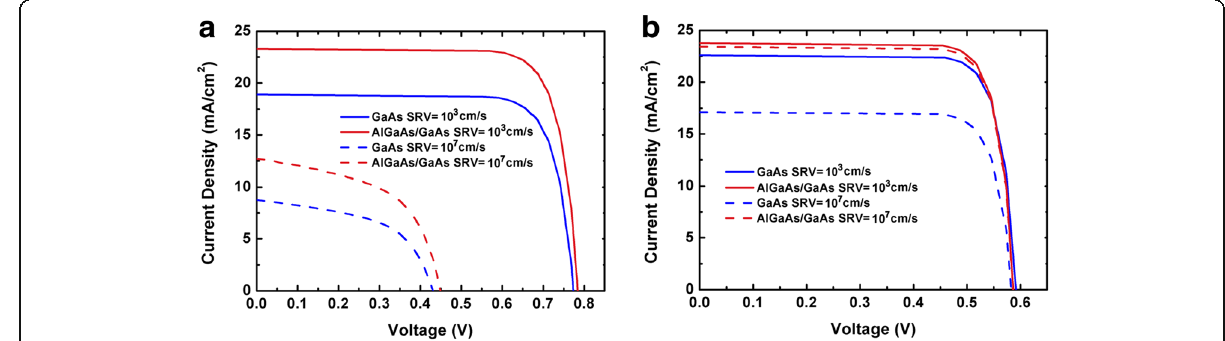
Fig. 3 The current – voltage characteristics of the GaAs and AlGaAs/GaAs nanowire a axial and b radial pin junction solar cells with surface recombination velocities of 10 3 and 10 7